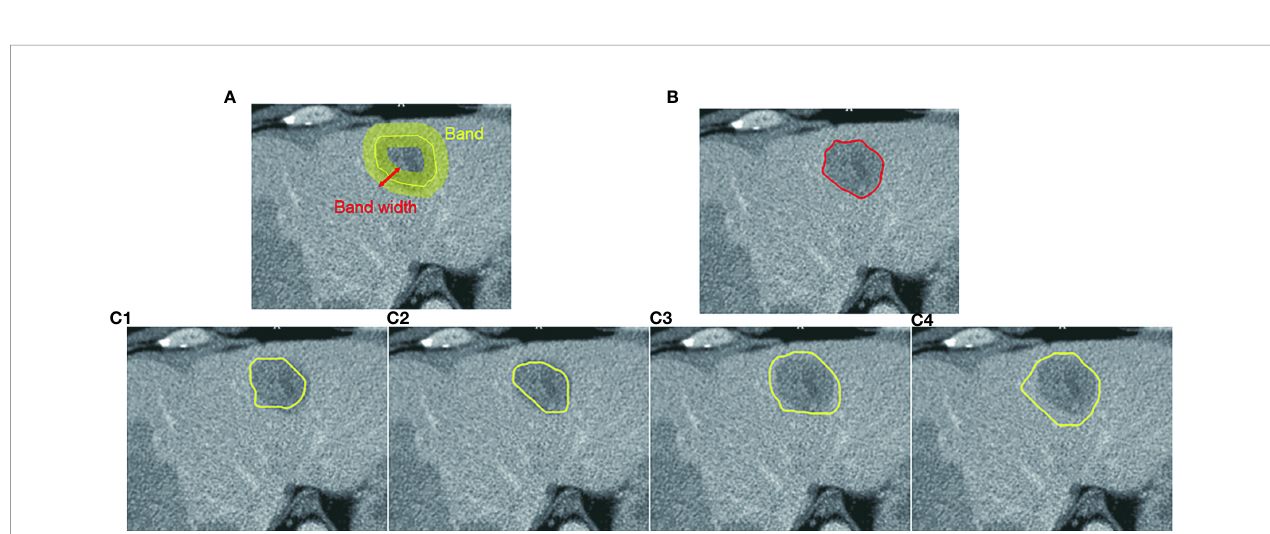
FIGURE 4 | Computer-aided contouring (CAC) tool. (A) Tumor boundary is searched within a band centered by the mouse moving trajectory. (B) The resulting boundary is the optimal path searched in terms of the minimum cost of local edges. (C1 – C4) Different mouse moving trajectories result in the same tumor boundary shown in (B) after applying the CAC